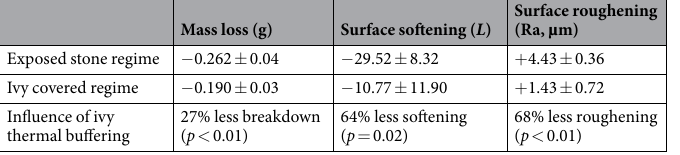
Table 2. Indicators of breakdown (mass loss, surface softening and roughness) for Elm Park Limestone after being subjected to ‘exposed stone’ and ‘ivy covered’ frost weathering simulations (mean ± SD, n =